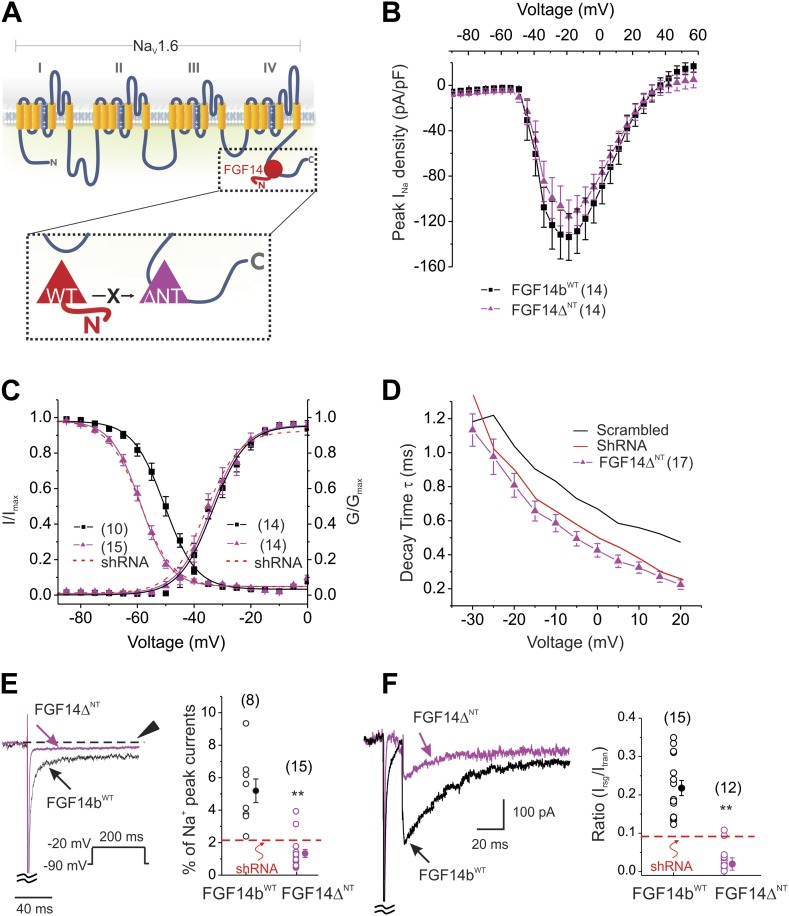
Expression of the dominant negative FGF14ΔNT affects multiple NaV channel biophysical properties indicating essential roles for the FGF14 N-terminus.(A) Schematic of endogenous wild type (WT) FGF14 binding to the C-terminus of the NaV1.6 α subunit (top) and magnified schematic of the expressed FGF14ΔNT preventing binding of the WT FGF14 (in box). (B) Current–voltage relationships (normalized to cell capacitance) of transient NaV currents from cerebellar Purkinje neurons transfected with FGF14bWT or FGF14ΔNT. The number of neurons tested, N, is in parentheses. The current–voltage relationship for Scrambled control shRNA (from Figure 1) is shown for comparison. (C) Voltage dependence of NaV channel activation and steady-state inactivation in cerebellar Purkinje neurons transfected with FGF14bWT or FGF14ΔNT. The number of neurons tested, N, is in parentheses. The curves for Scrambled control shRNA (from Figure 1) are shown for comparison. (D) τ of inactivation at the indicated test voltages. The number of neurons tested, N, is in parentheses. (E) Exemplar normalized TTX-sensitive late NaV currents at −20 mV (measured at 150 ms, arrowhead) from a holding potential of −90 mV. The number of neurons tested, N, is in parentheses. **p < 0.01. (F) Overlay of NaV resurgent currents recorded from cerebellar Purkinje neurons transfected with FGF14ΔNT or FGF14bWT and ratio of peak NaV resurgent current (at +20 mV) to transient NaV current (at −10 mV). The number of neurons tested, N, is in parentheses. The average for FGF14 shRNA knockdown (Figure 1) is shown for comparison. **p < 0.01.